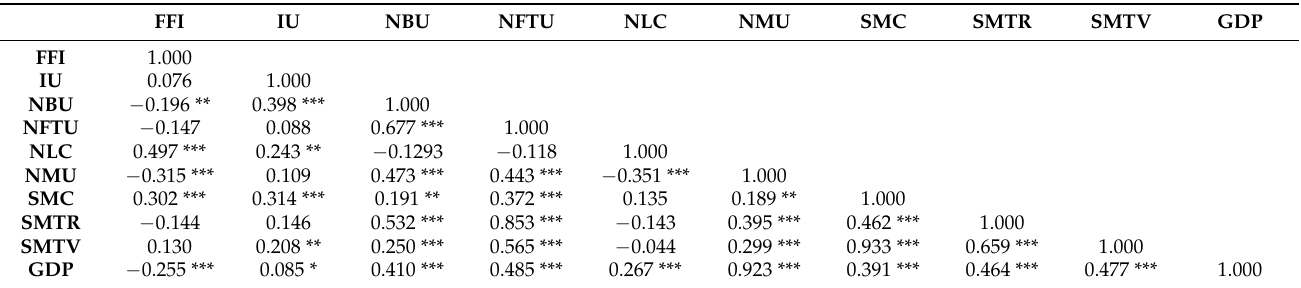
Table 5. Correlation